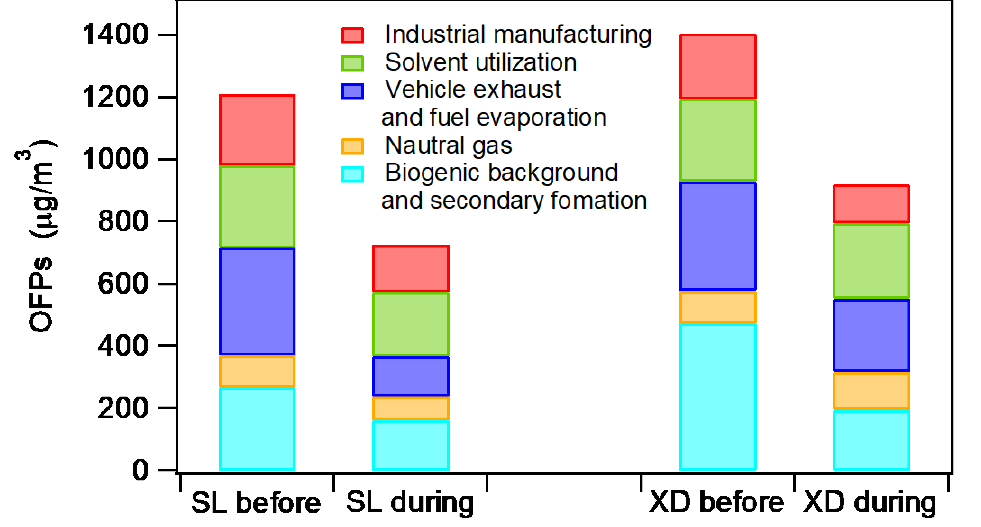
Figure 10. The contribution of individual sources to the total OFP of all sources extracted from PMF.